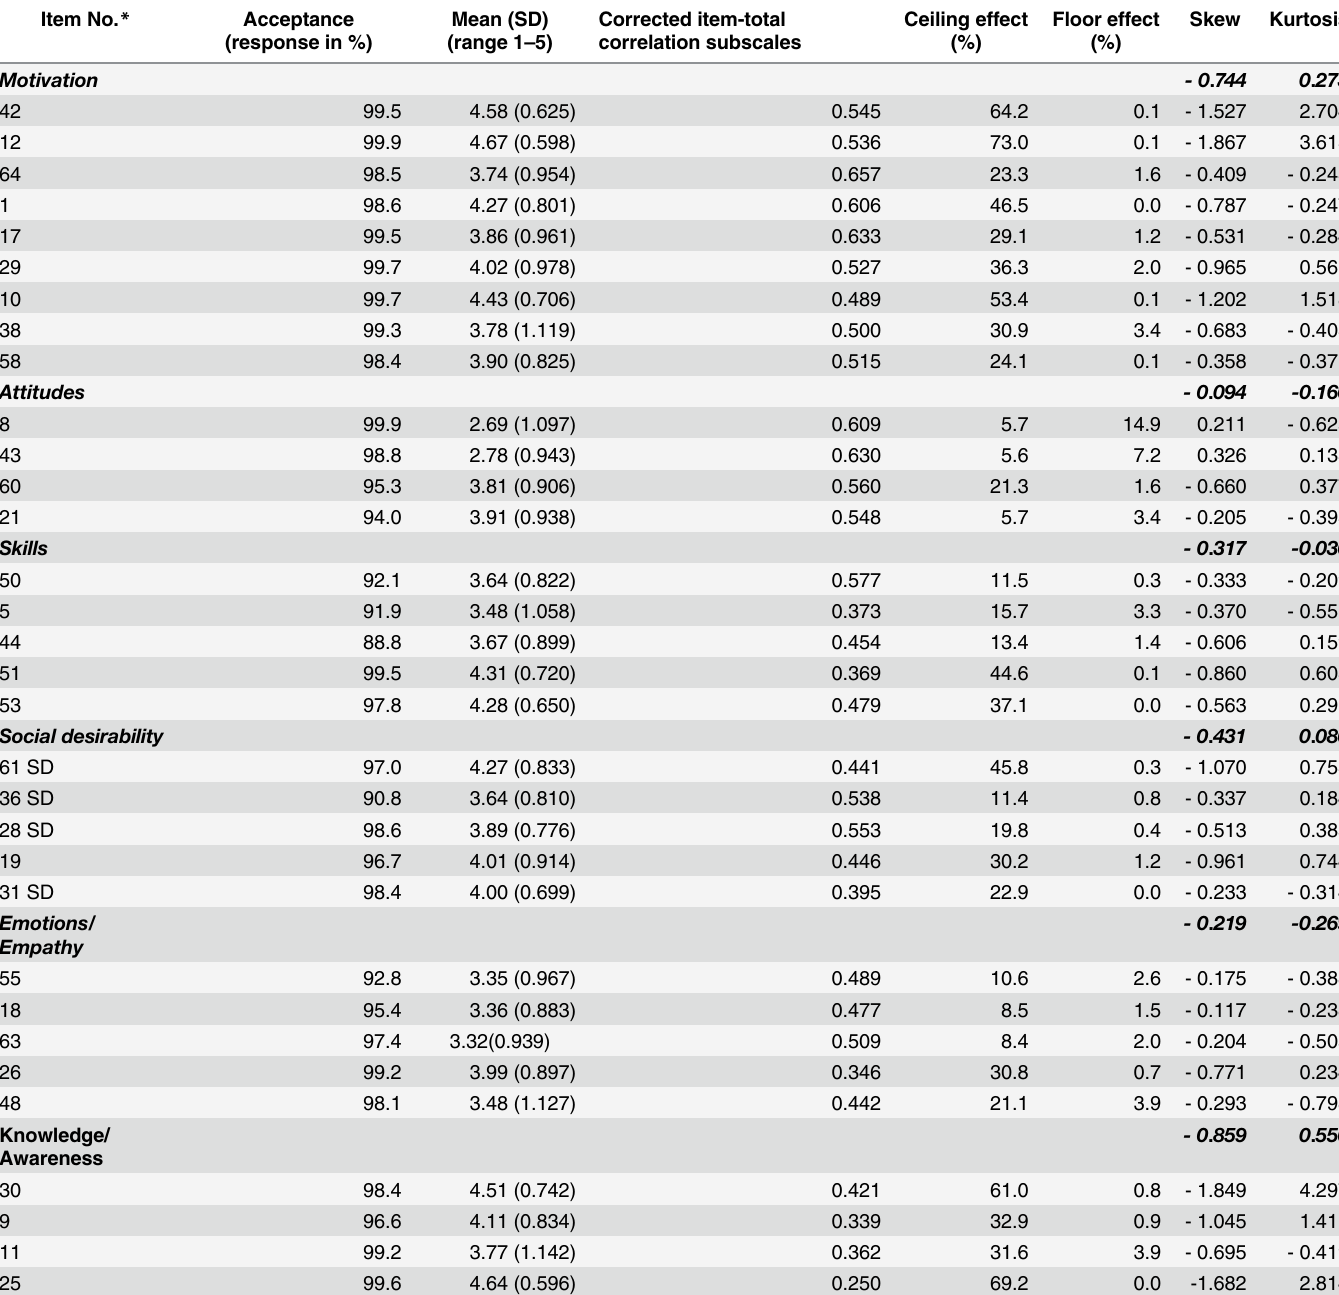
Table 4. Item/Subscale